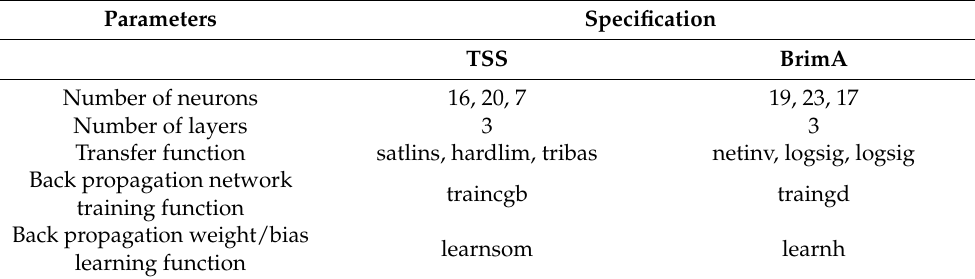
Table 2. Structure of the hidden layers of ANN-ICA to predict TSS and BrimA. Parameters